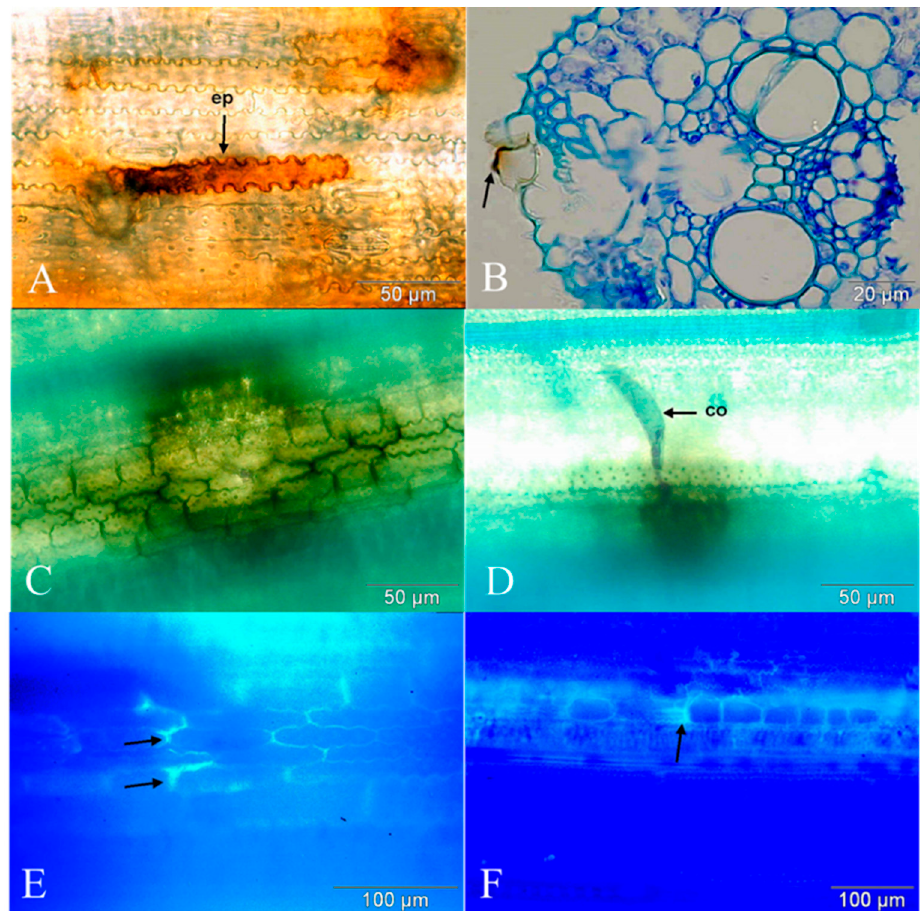
Figure 3. Details of infection biology and defence responses of rice cv. MTL189 infected by Bipolaris oryzae K2 (less compatible interaction) and isolate B5 (compatible interaction). ( A ) DAB staining showing hydrogen peroxide accumulation in FEC at 12 hai (isolate K2). ( B ) Cross section of similarly DAB-stained area (isolate K2) at 12 hai, arrow showing staining in the outer epidermal cell wall. ( C ) Accumulation of polyphenolic substances, seen as greenish-turquoise staining, as a response to infection attempt by isolate K2 at 72 hai. ( D ) Polyphenolic accumulation as a response to infection attempt by isolate B5 at 72 hai. ( E ) Callose indicated by fluorescence (arrows) as a response to infection attempt by isolate K2 at 144 hai. ( F ) Callose indicated by fluorescence (arrow) as a response to infection attempt by isolate B5 at 144 hai. Abbreviations as in Figure 1.